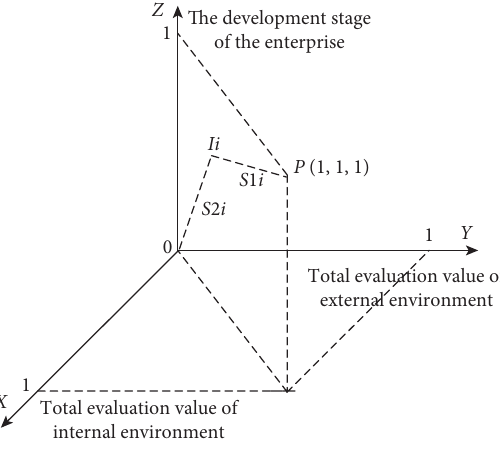
Figure 2: Schematic diagram of S